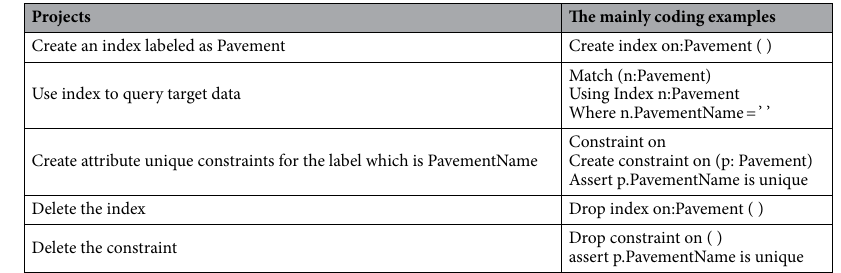
Table 3. The mainly coding examples for the methods of optimization.